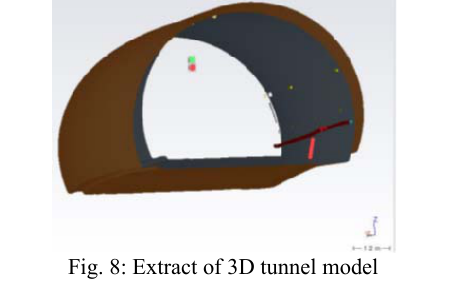
Fig. 8: Extract of 3D tunnel model